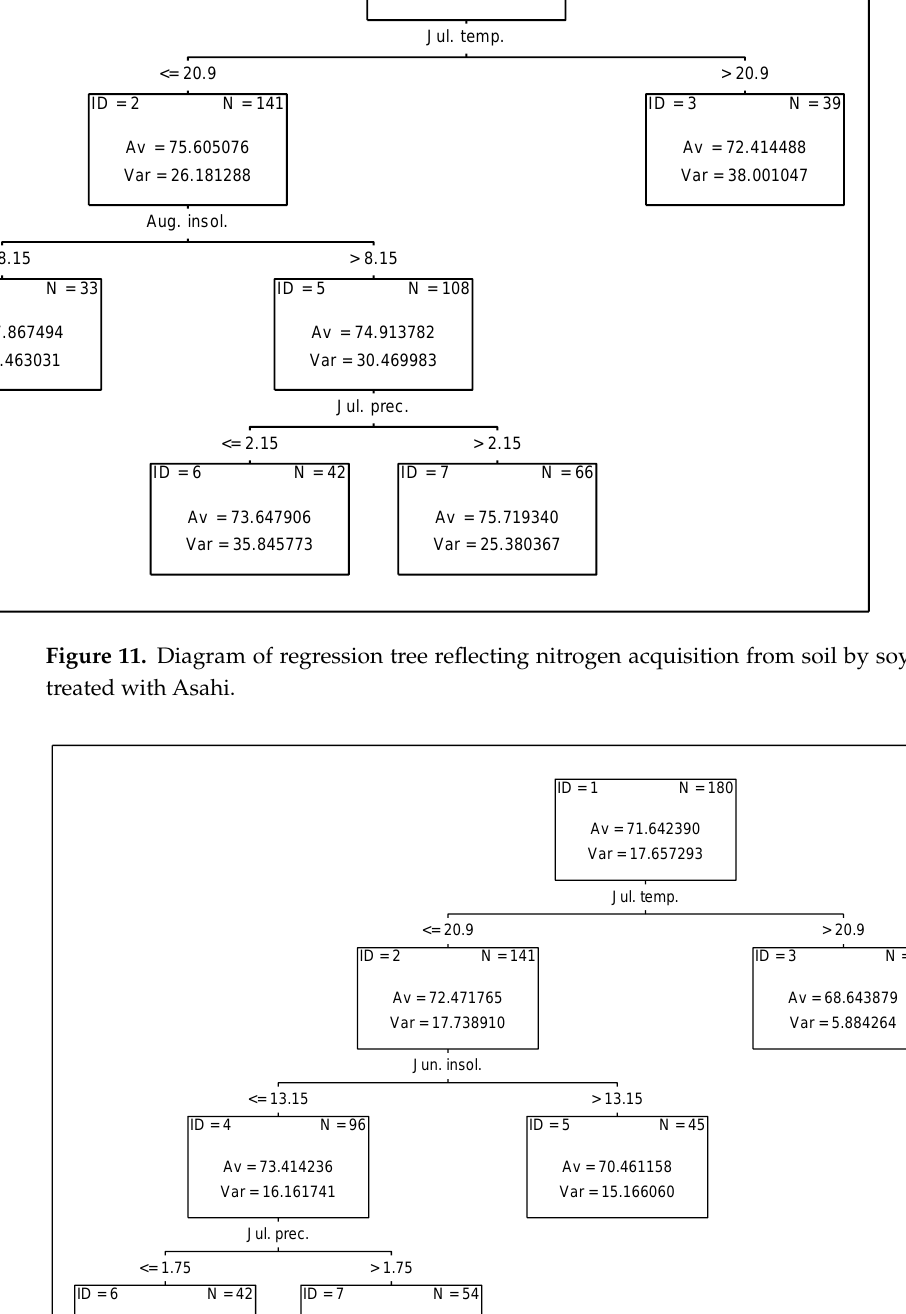
Figure 12. Diagram of regression tree reflecting nitrogen acquisition from soil by soybean plants treated with Improver.